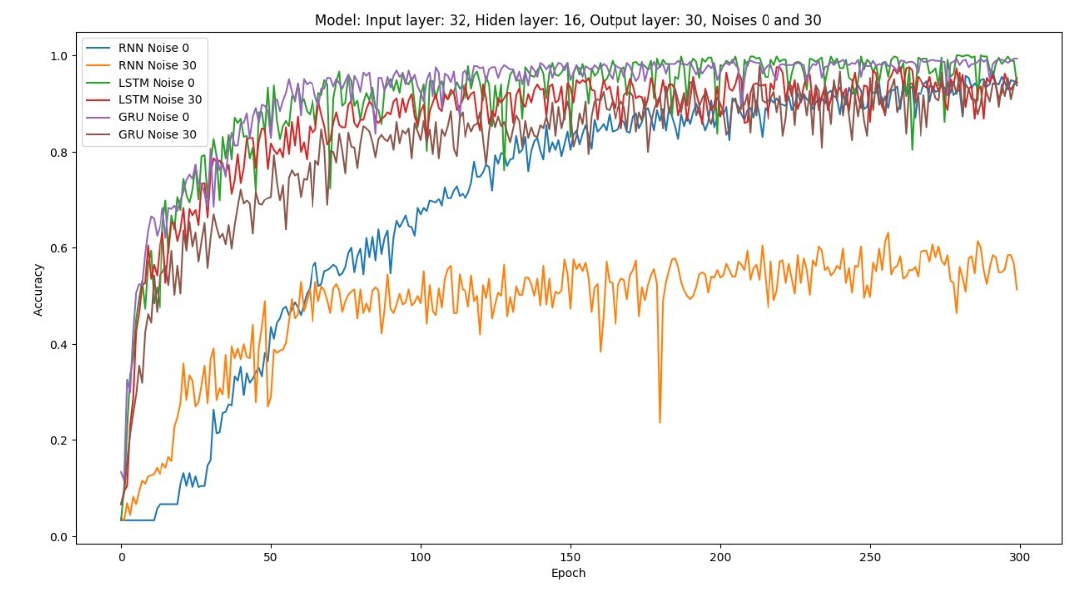
Figure 5. Training curves for the models with 32 neurons. Best seen in